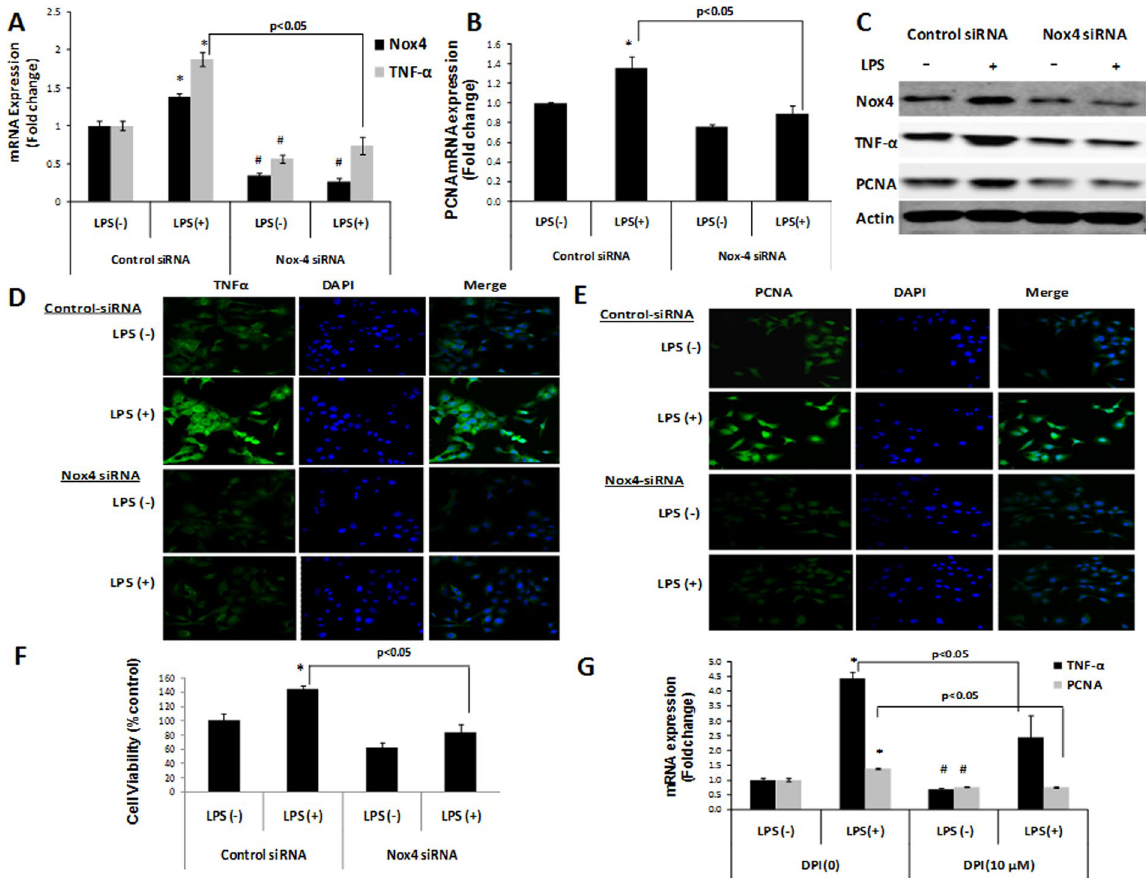
Figure 3. Nox4 siRNA and DPI suppressed LPS induced TNF- α and PCNA elevation. Nox4, TNF- α ( A ) and PCNA ( B ) mRNA levels were analyzed by qRT-PCR in Huh7 cells transfected with control or Nox4 siRNA for 48 hrs, and either treated with LPS or PBS for an additional 3 hrs. ( C ) Nox4, TNF- α and PCNA protein levels were determined by western blotting in Huh7 cells treated with controlor Nox4 siRNA for 48 hrs, and either treated with LPS or PBS for an additional 3 hrs. Actin was used as a control for protein loading. ( D , E ) Huh7 cells treated with controland Nox4 siRNA for 48 hrs,and either untreated or treated with LPS for an additional 3 hrs were analyzed for the cellular level of TNF- α ( D ), and PCNA ( E ) protein by confocal microscopy. Confocal microscopic fields are shown in ( D , E ), a representative picture of three independent experiments. ( F ) Huh7 cells transfected with control and Nox4 siRNA for 24 hrs, and either treated with LPS or PBS for an additional 24 hrs. Then, cell numbers were measured by cell proliferation assay. ( G )TNF- α and PCNA mRNA levels were analyzed by qRT-PCR in Huh7 cells either untreated or pretreated with DPI (10 µ M) for 30 minutes before 3 hrs of LPS stimulation. * indicates statistically significant difference from the corresponding controls (p < 0.05). # indicates statistically significant difference from control siRNA LPS ( − ) or DPI (0) LPS ( − ) (p < 0.05). Lines with p values also indicate statistically significance (p < 0.05) between the